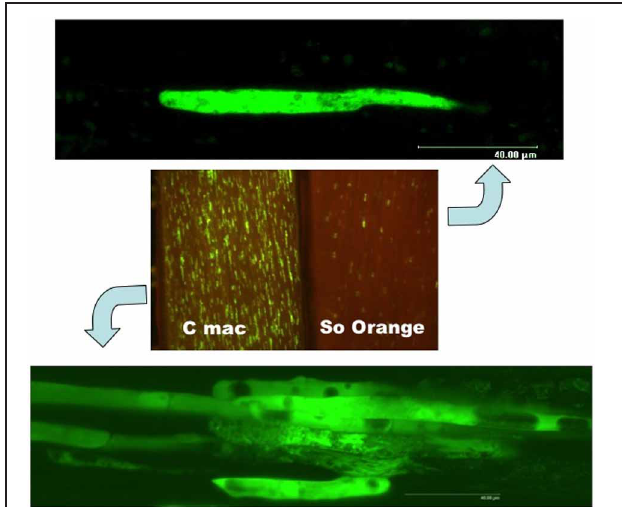
FIGURE 2 | Detection of GFP fluorescence in phloem-associated cells of Citrus macrophylla (C mac) and sour orange (So Orange) under a fluorescence-dissecting microscope (center) or a confocal laser scanning microscope showing single cell infections (top) and multiple cell infections